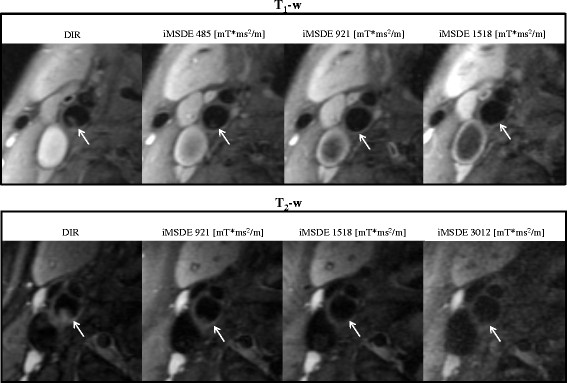
Examples of iMSDE first order moment optimization in volunteers. T1-w imaging with 485 mT*ms2/m and T2-w imaging with 1518 mT*ms2/m produced excellent blood suppression and SNR.